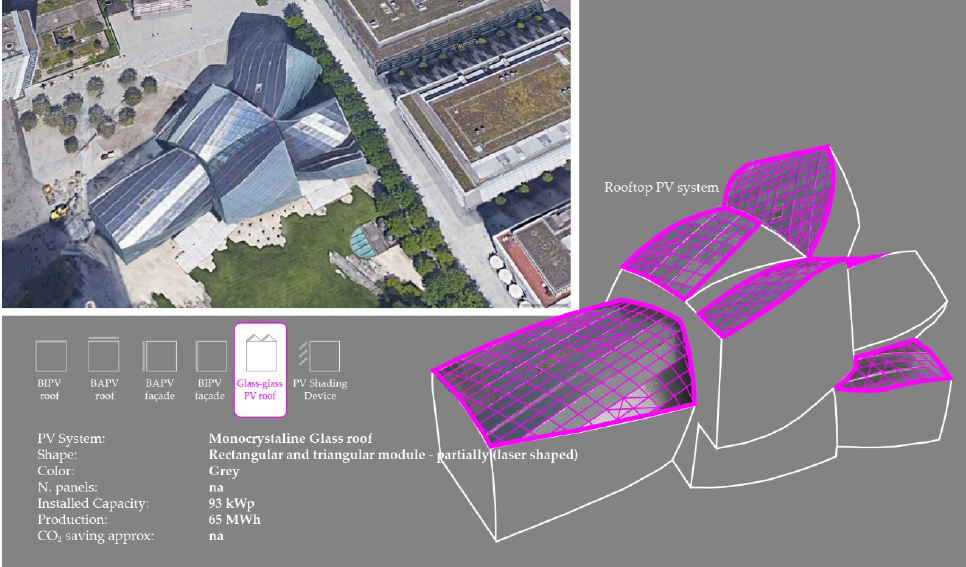
Figure 13. Novartis Campus (top view of the building. Source of illustration Google Earth, Google 2020) ( on the top left ). Integration and characteristic of PV systems ( on the bottom ).